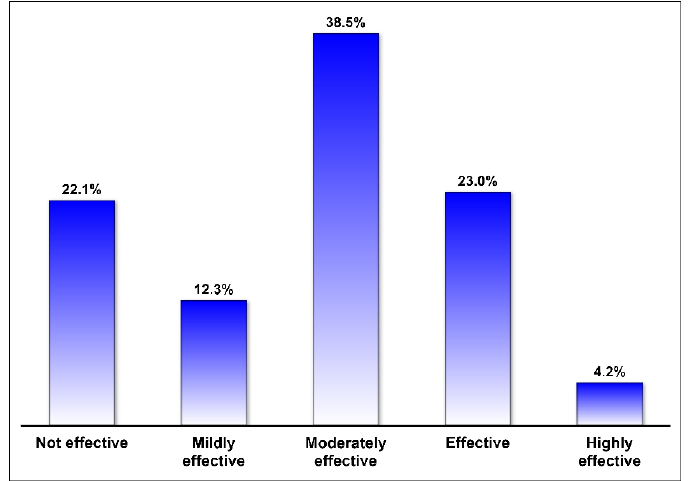
Figure 2. The rating of hyaluronic acid in the management of osteoarthritis.